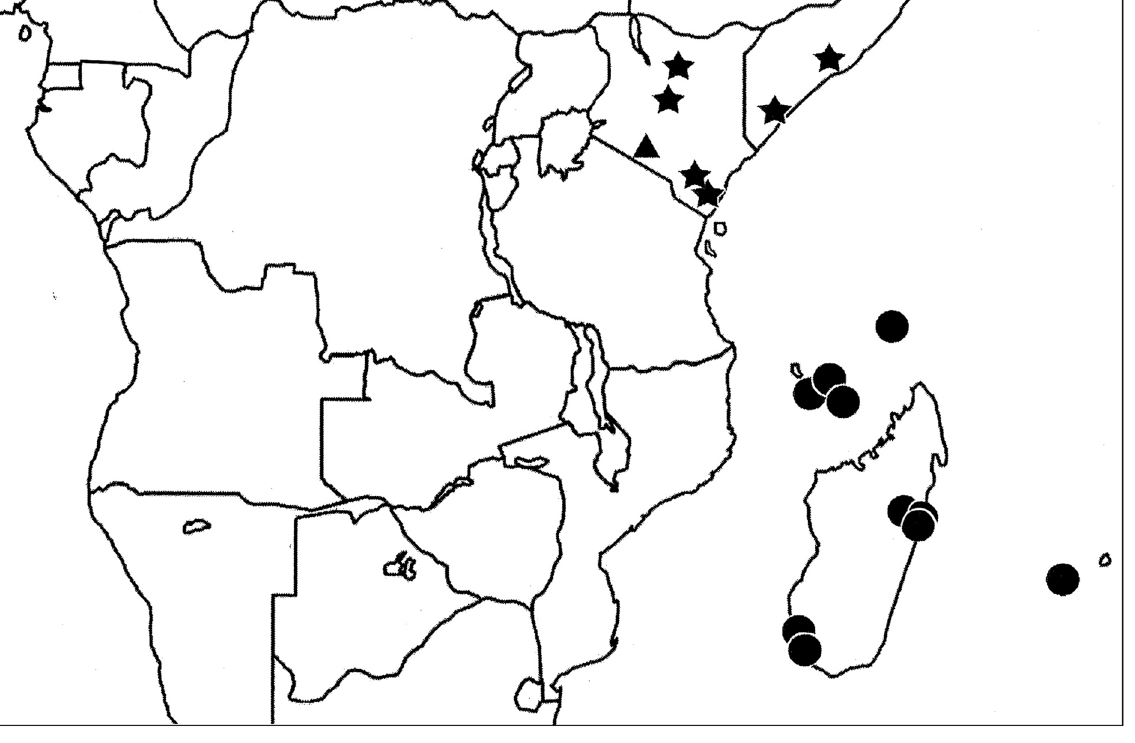
Fig. 9. Collection localities for Wadicosa benadira (Caporiacco) (stars), W. cognata sp. nov. (triangle) and W. jocquei sp. nov. (circles). One symbol may refer to more than one